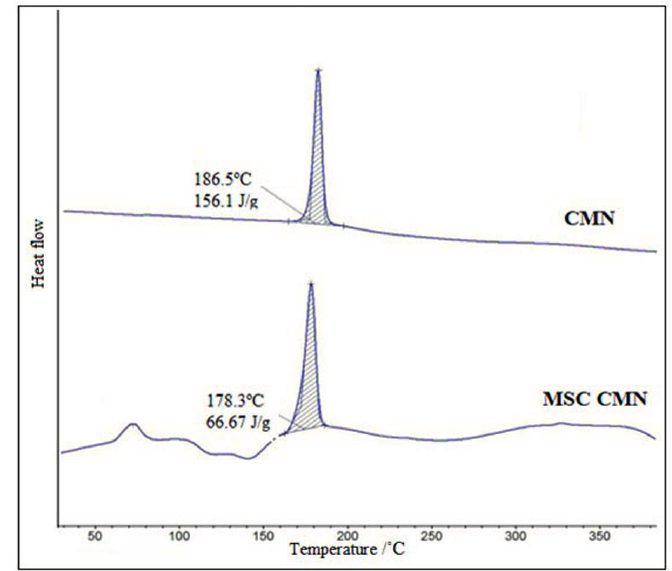
Figure 5. DSC thermogram profile of CMN and MSC CMN.